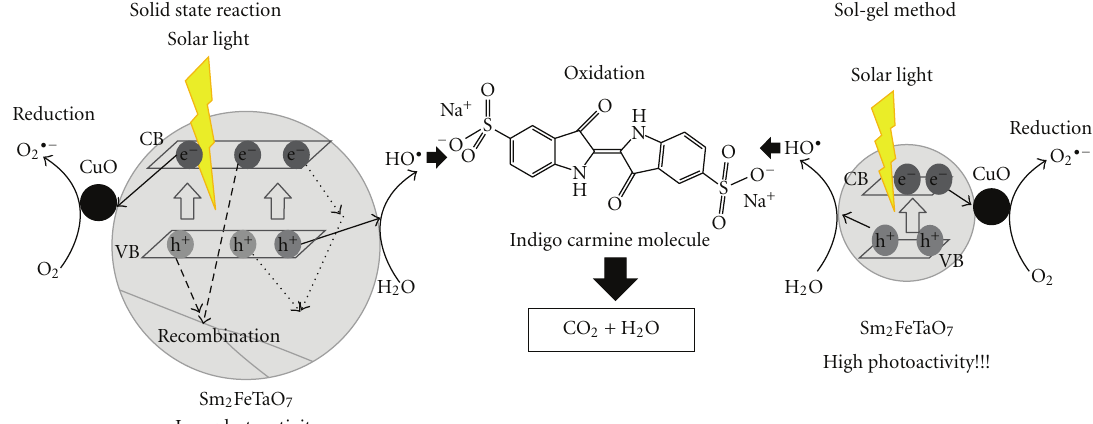
Figure 8: Schematic mechanism of the photocatalytic degradation of indigo carmine dye. CB conduction band and VB valence band.